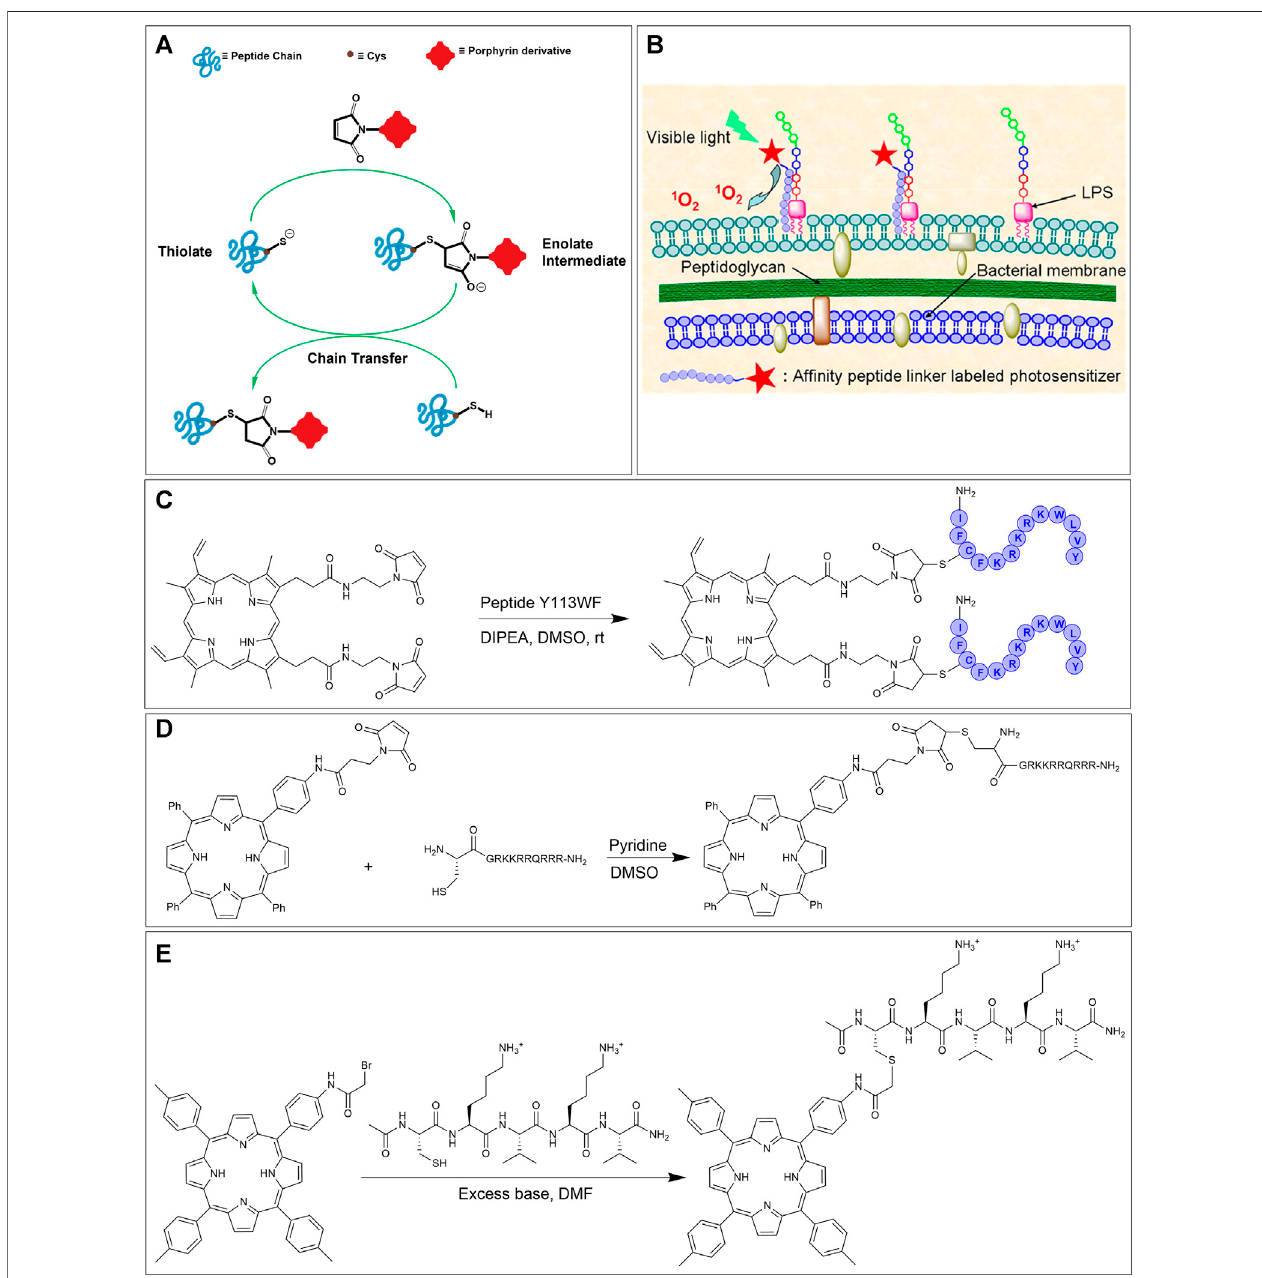
FIGURE 9 | (A) Thiol-maleimide ligation mechanism. (B) Schematic of the binding of PpIX-Y113WF conjugate to LPS component of Gram-negative bacterial strains.Adaptedwithpermissionfrom(Liuetal.,2012). (C) Thiol-maleimidereactionofdimericprotoporphyrinIXandcysteine-containingantimicrobialpeptideY113WF. (D) Bioconjugation of maleimide functionalized porphyrin derivative with a thiol tethered CPP (Dondi et al., 2016). (E) Synthetic scheme for the preparation of peptide- porphyrin conjugate using the bromoacetamide-cysteine reaction. (Arai et al., 2003).